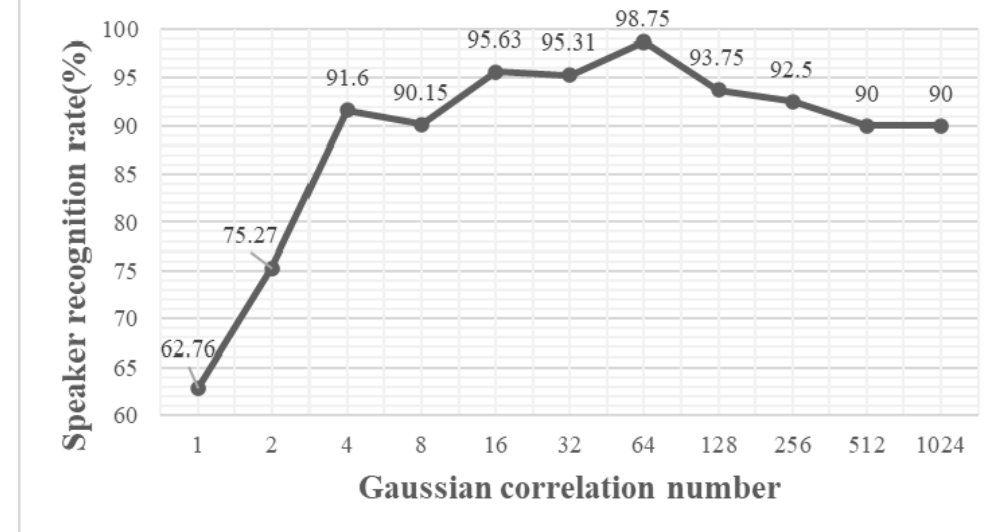
Figure 8. Speaker recognition results based on the proposed fusion model.